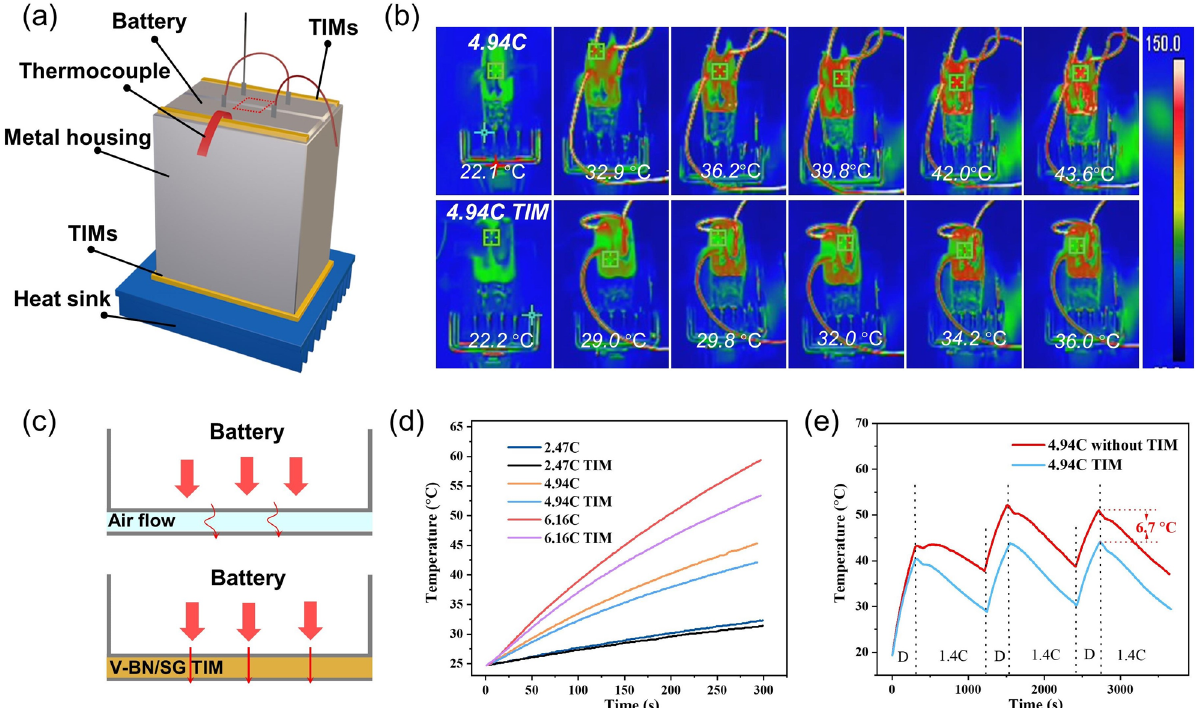
Fig. 7 Battery thermal dissipation performance of 60 V-BN/SG (0.2–2) strips. a Schematic illustration of the TIMs temperature measurement system in the battery setup. b IR images of the top surface of batteries with and without V-BN/SG strips as TIMs under 4.94C discharging rate at room temperature. c Schematic of TIMs used to bridge the battery and metal housing. Temperature revolution of the battery surface measured by a thermocouple as a function of time d under 2.74C, 4.94C, 6.16C discharging rate, and e during three charging (1.4C)-discharging (4.94C)